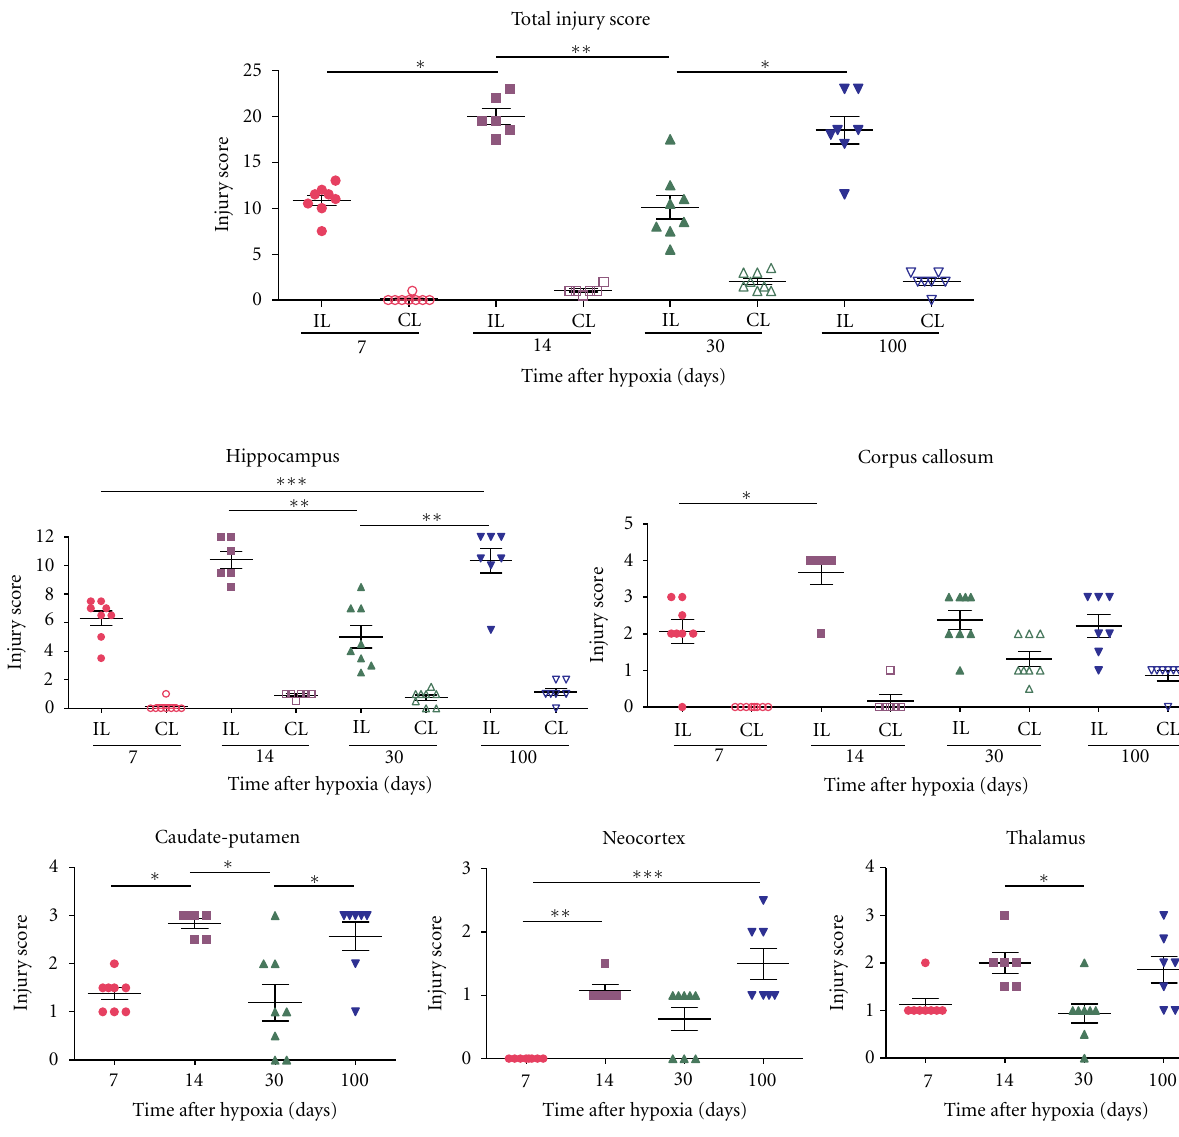
Figure 5: Graphs showing the changes in the total injury score along with the injury score in di ff erent regions analyzed after 7 to 100 days after hypoxia following Nissl staining. Kruskal Wallis test was done followed by Dunn’s multiple comparison test. ∗ P < 0 . 05, ∗∗ P < 0 . 01, ∗∗∗ P < 0 . 001 is considered